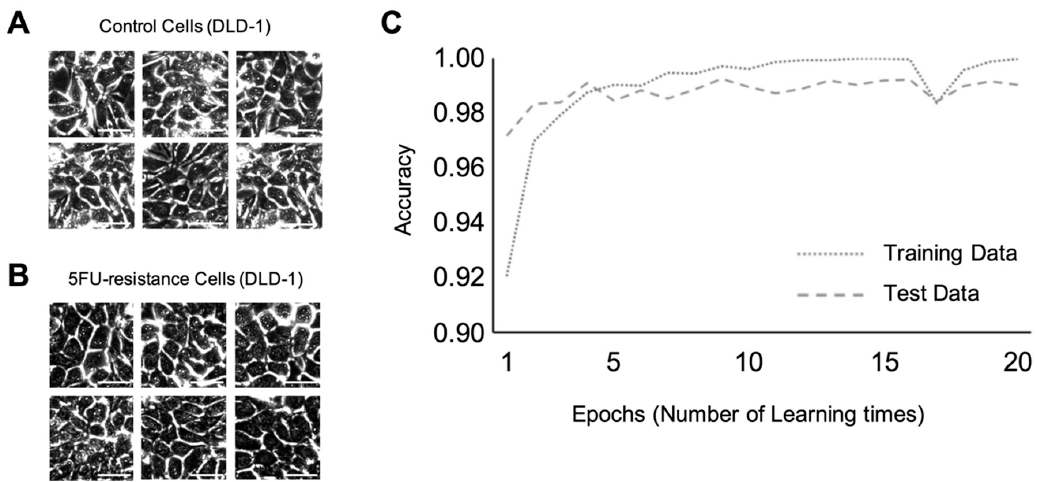
Figure 2. Machine learning at confluence level for DLD-1 cells resistant and non-resistant to anticancer drugs. Scale bar; 50µm ( A ) Representative input image of the control DLD-1 cells. Scale bar; 50µm ( B ) Representative input image of anticancer drug-resistant DLD-1 cells. ( C ) Accuracy variation per epoch.